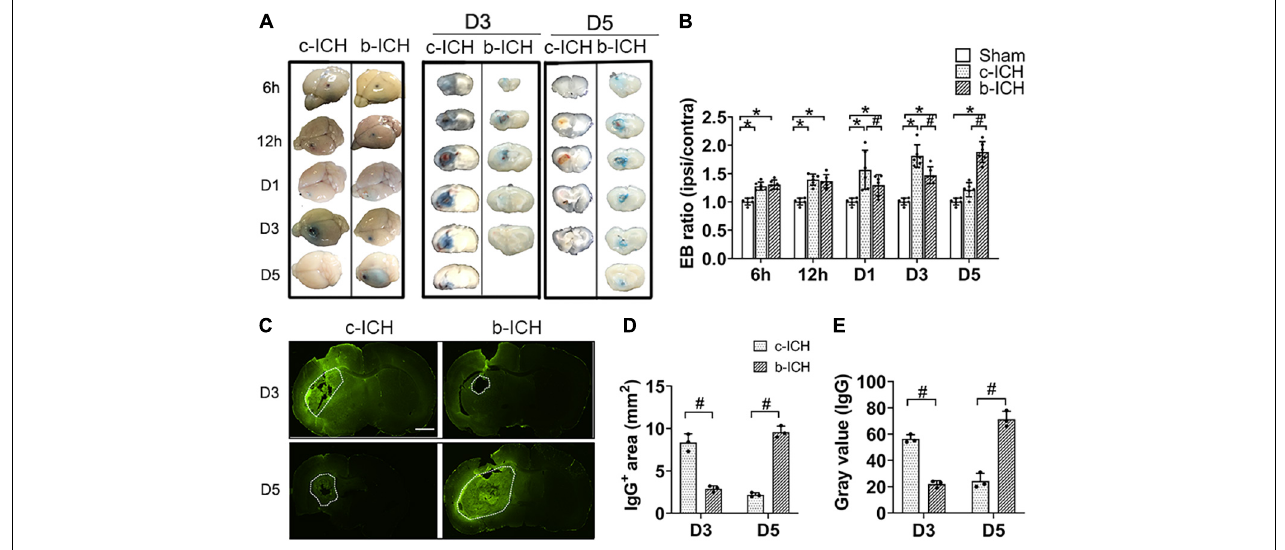
FIGURE 3 | The comparison of BBB breakdown between the c-ICH and the b-ICH groups. (A) The Evans blue staining showed that BBB leakage was present from 6 h to day 5 after ICH in two groups. (B) Quantitative analysis showed that the Evans blue (EB) concentration peaked at day 3 in the c-ICH group but on day 5 in the b-ICH group ( n = 6 mice/group for each time point; * P < 0.05 vs. sham group, # P < 0.05 vs. the c-ICH group; repeated measures ANOVA followed by Bonferroni post-hoc test). (C) The IgG-positive area was determined by immunohistochemical staining on days 3 and 5, respectively (scale bar = 1 mm). (D,E) Quantification of endogenous IgG-positive area and gray values of IgG immunostaining; n = 3 mice/group; # P < 0.05 vs. c-ICH group ( t -test). Values are Mean ± SD.